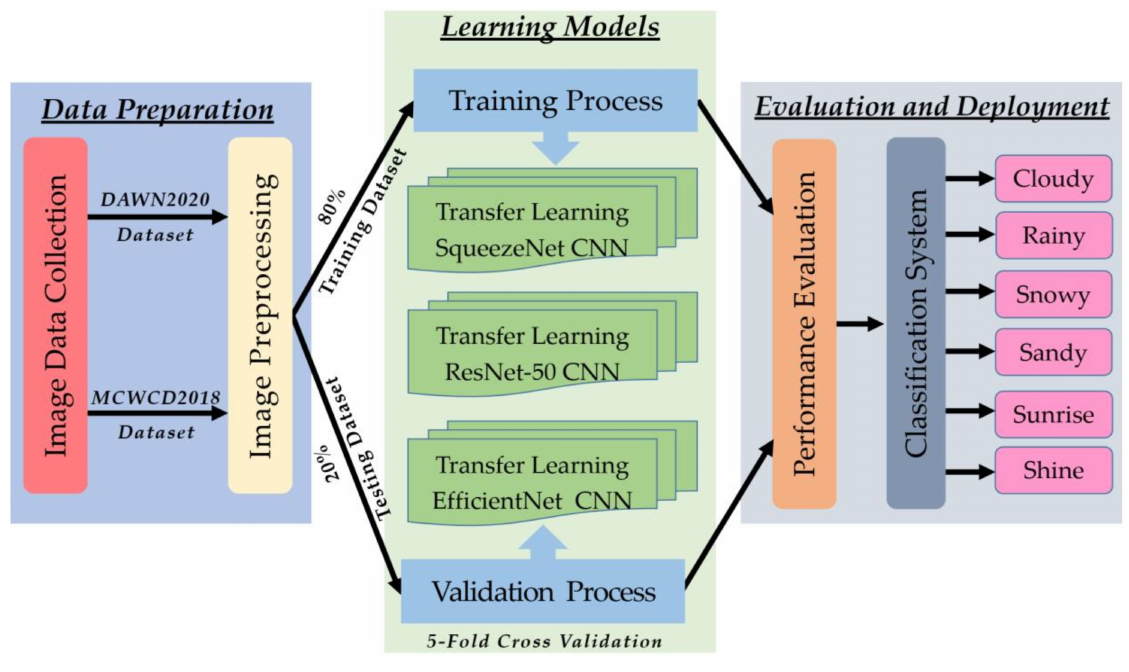
Figure 2. Architectural diagram of the proposed